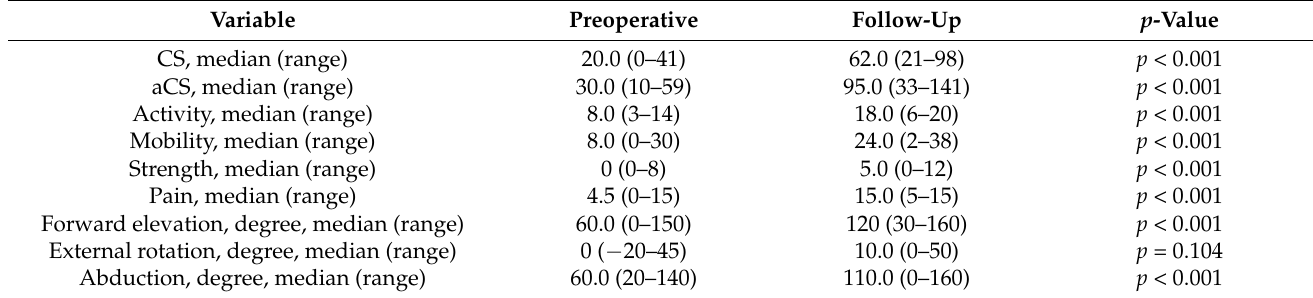
Table 2. Clinical outcomes. CS= Constant Score; aCS= age- and gender-adjusted Constant Score.